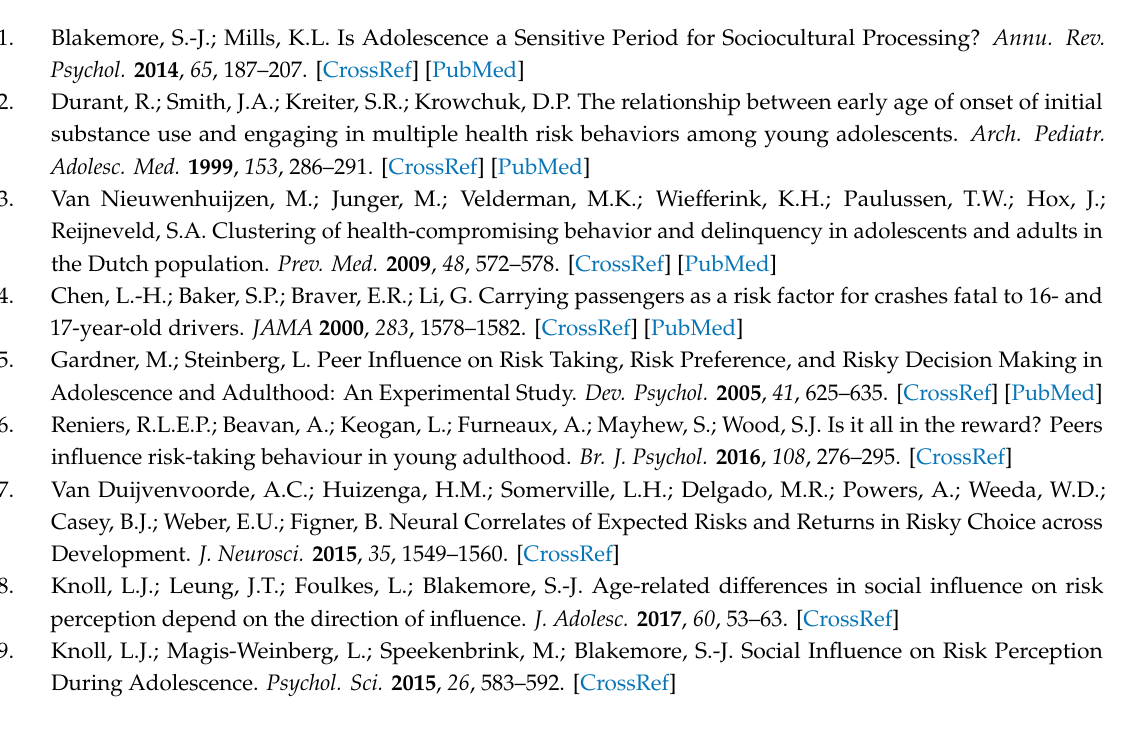
Table S1: Health and Social Risk Questionnaire